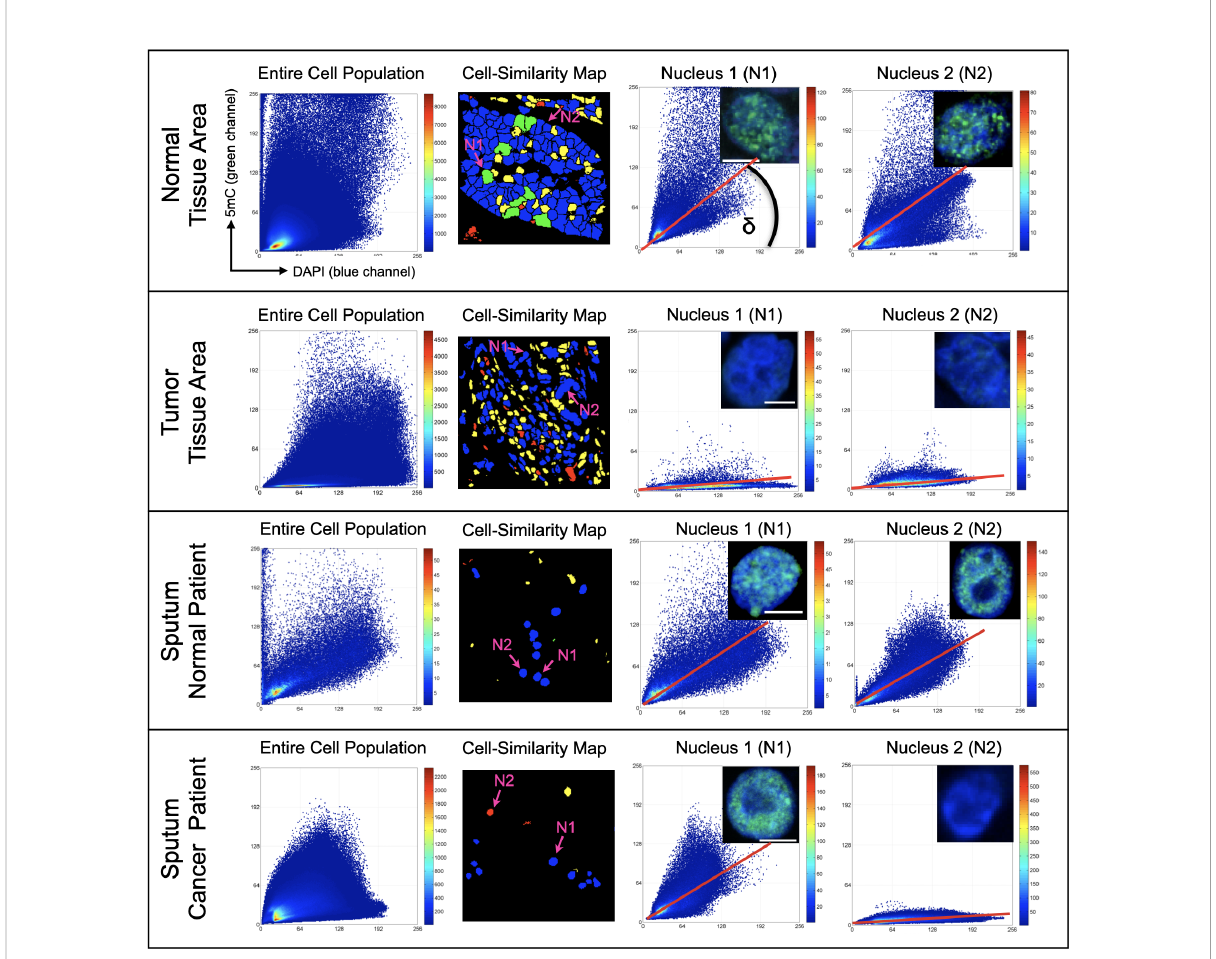
FIGURE 3 Comparative DNA methylation phenotyping of patient tissues and matching sputum. The normal lung epithelium as well as the normal sputum contain a majority of epithelial cells that display nuclear 5mC features with a high degree of similarity to the patterns seen in BEAS-2B cells. The two cell sources appear quite homogeneous in terms of 5mC topology. In contrast, the tumoral region appears more heterogeneous and contains a majority of severely hypomethylated cells. The selected nuclei N1 and N2 in the fi rst three respective panels represent the most prevalent 5mC topology for the normal tissue and sputum as well as for the tumor area. The sputum from cancer patients contained severely hypomethylated cells amongst normally methylated cells. For this case the selected nuclei differ in 5mC indices: cell nucleus N1 represents the normally methylated cell whereas N2 constitutes an aberrantly hypomethylated cell. White bars are 5